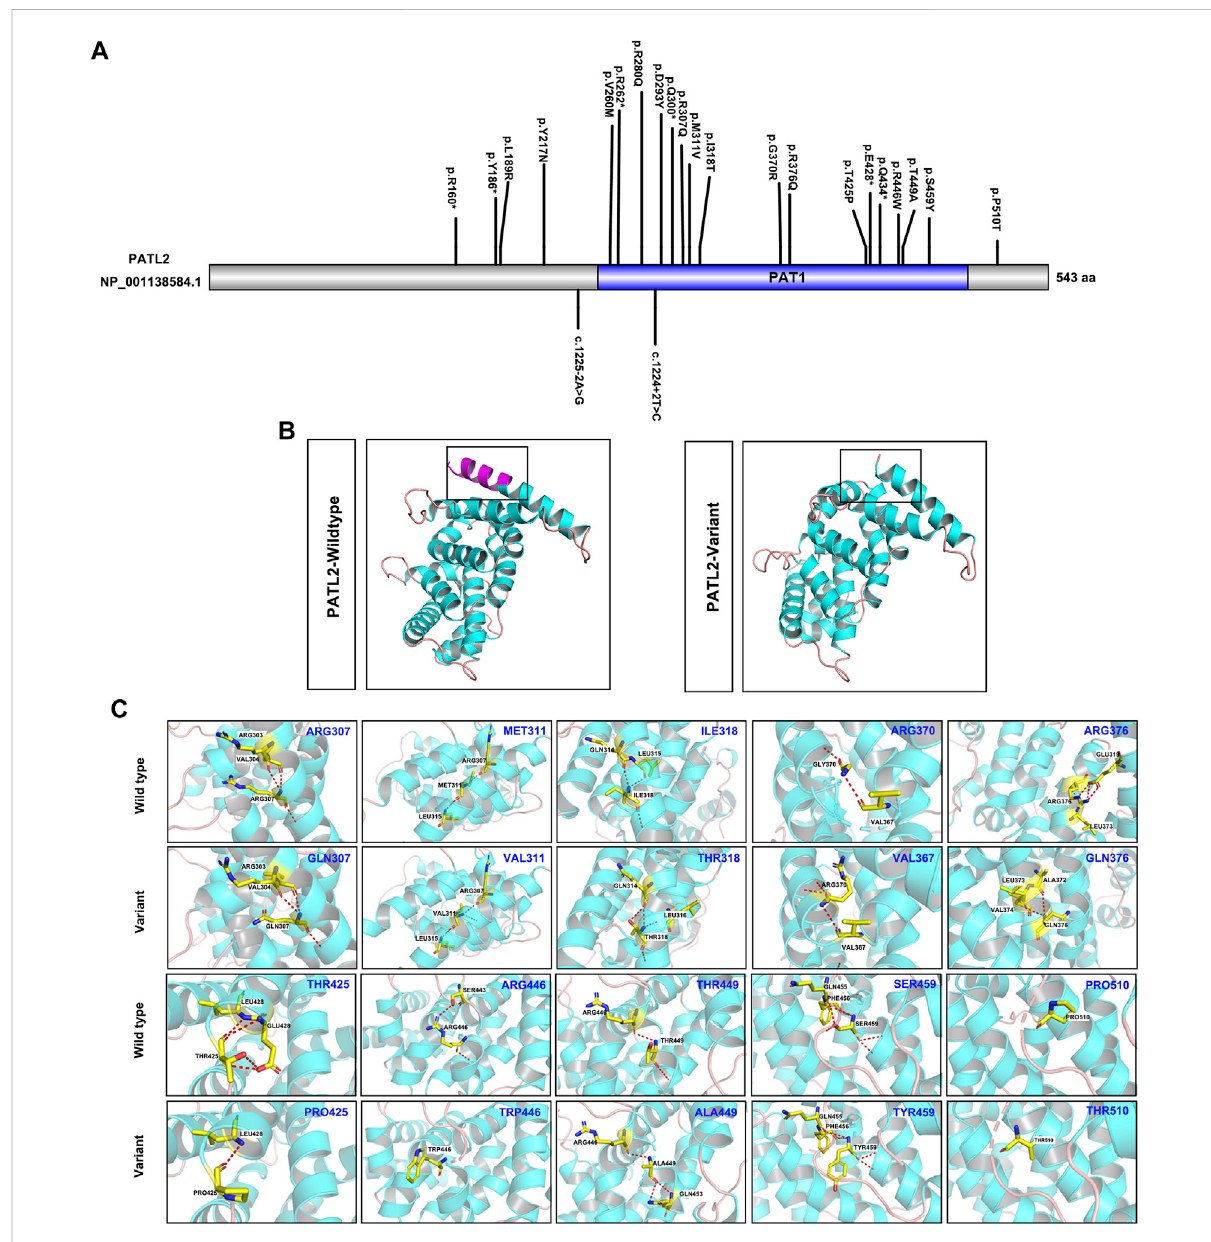
FIGURE 4 Schematic diagrams of the locations of reported PATL2 variants and molecular modelling of wild-type and mutant PATL2 proteins. (A) The variantsmarkedarethe PATL2 variantsreportedtodate,andthenovelvariantidenti fi edinthepresentstudyismarkedandindicatedinred. (B) Three- dimensionalschematicofthestructureofnormalPATL2protein(ontheleft)andthemutantPATL2(ontheright).A18-amino-acidin-framedeletion p. (Asp293_Lys310) in the PAT1 domain of the PATL2 protein is the putative result of the homozygous splicing variant (C) 871-1G > A. The alteration in the three-dimensional positioning of the splicing variant causes steric hindrance to the formation of α -helix structures in the PATL2 protein, which are highlighted inpink. (C) Three-dimensional schematic of the structure of the previous reported missense variants of PATL2